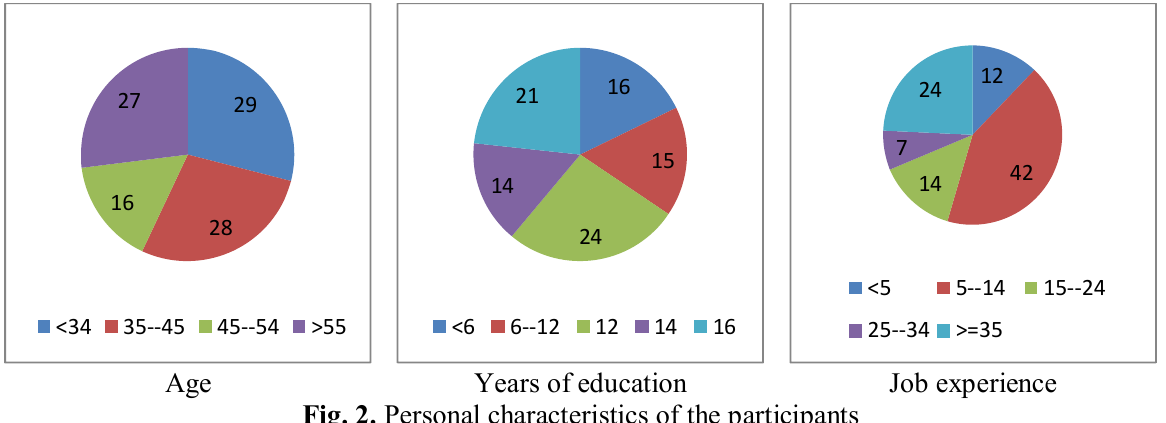
Fig. 2. Personal characteristics of the